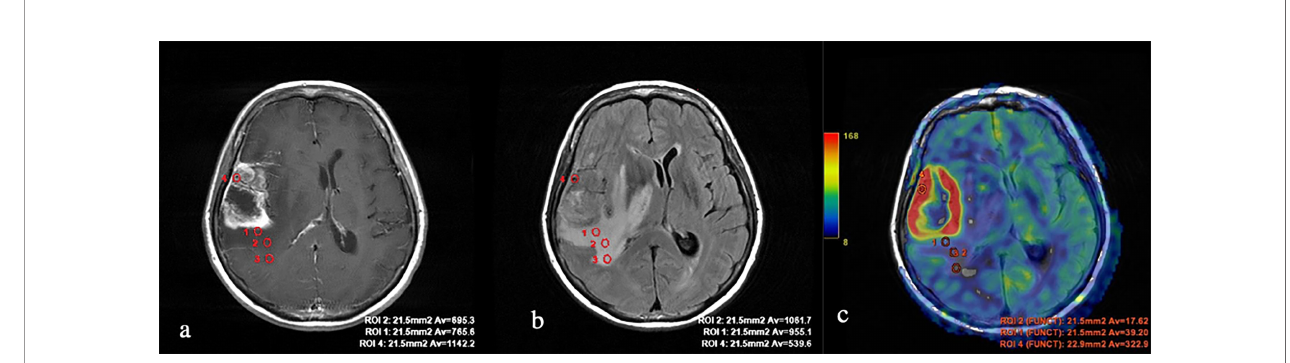
FIGURE 3 | Glioblastoma. (A) T1 with contrast enhancement; (B) T2-FLAIR; and (C) TBF blood fl ow maps aligned with T2-FLAIR. Measurements of hemodynamic parameters of tumor blood fl ow in the peritumoral zone are shown.